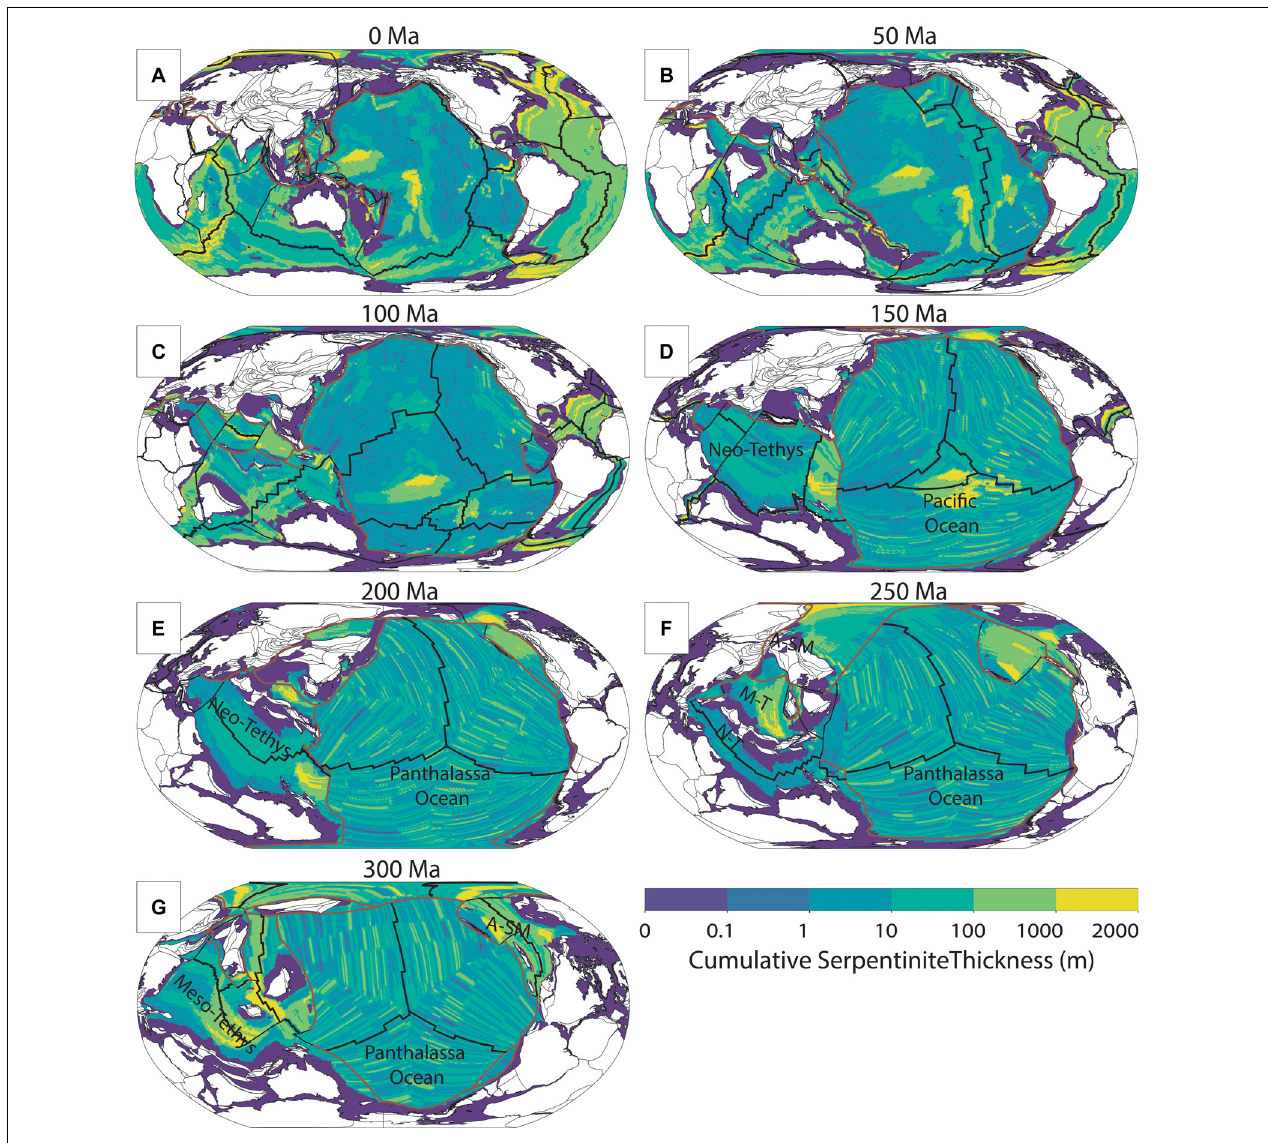
FIGURE 9 | (A–G) Cumulative thickness of serpentinite formed near mid-ocean ridges and transported in the upper oceanic lithosphere through ocean basins toward subduction zones since 300 Ma in 50 Ma intervals (see Supplementary Material 4 for 1 Ma grids and rasters, and Supplementary Material 6 for an animation). Thicknesses calculated prior to 160 Ma are converted from vertical area to point thickness. Since Pangea breakup, our model suggests extensive serpentinite formation in the Arctic, Atlantic, and Indian oceans. A-SM, Alexander-Stoney Mountain ocean basin; M-T, Meso-Tethys Ocean; N-T, Neo-Tethys Ocean. Purple areas represent lithosphere not covered by our analysis or the plate model, such as submerged continental lithosphere or lithosphere trapped between a continent and a subduction zone (principally in the Palaeozoic), which would represent earlier (pre-400 Ma) oceanic crust. Black lines are mid-ocean ridges, brown lines are subduction